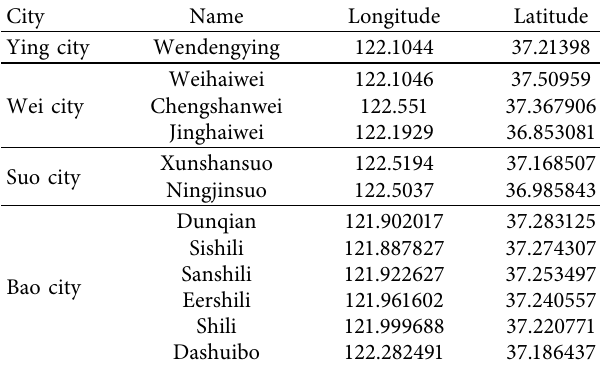
Figure 1: Location and administrative Table 1: Weihai City site data during the Ming dynasty. City Name